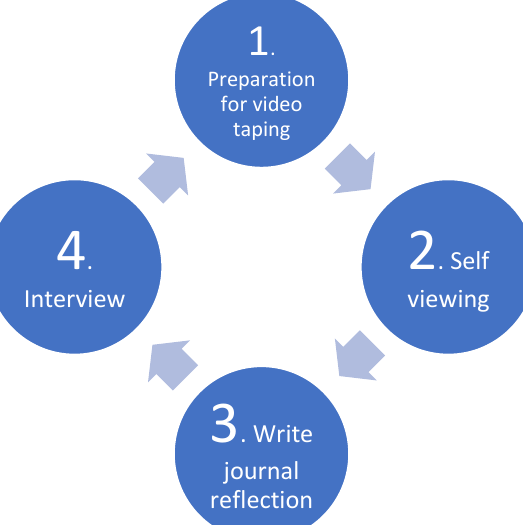
Figure 1. Orlova's (2009) video-elicited reflection